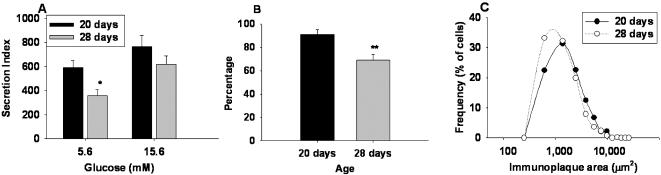
Insulin secretion at d20 and d28 explored by RHPA.(A) Bar graphs represent insulin secretion index at d20 and d28, in response to different glucose concentrations, mean ± SEM, n  =  4 experiments by duplicate, (*) p<0.05 with respect to 15.6 mM.
(B) Percentage of insulin secreting beta-cells from the total population as identified by insulin immunocytochemistry after the RHPA; mean ± SEM, n  =  4 experiments by duplicate, **p<0.0001 with respect to d20.
(C) Pancreatic beta cell subpopulations at d20 and d28 in response to basal, 5.6 mM glucose.Data pooled from 3 experiments by duplicate.